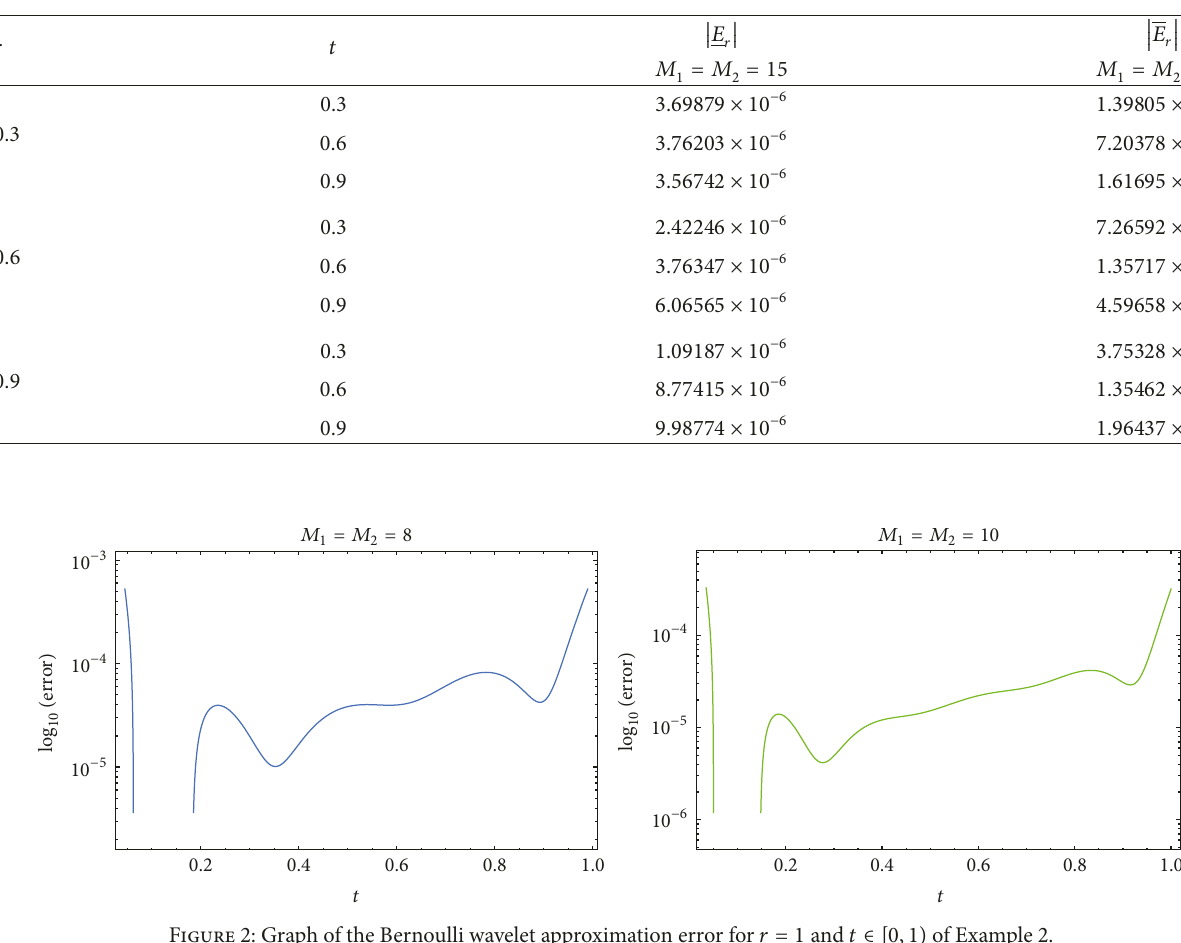
Table 2: The absolute errors for Example 2.